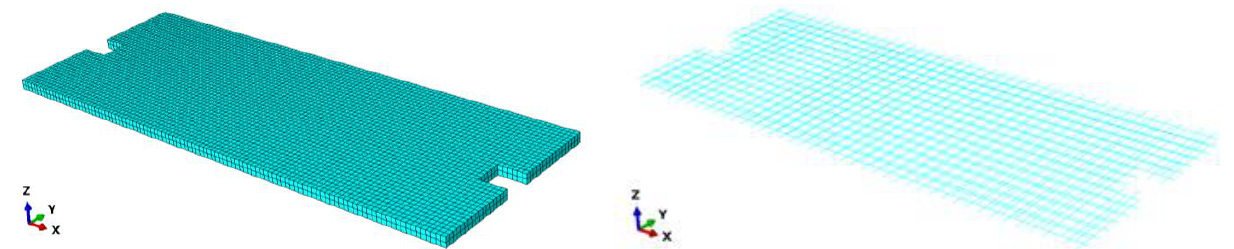
Figure 3. Grid division of the steel frame.